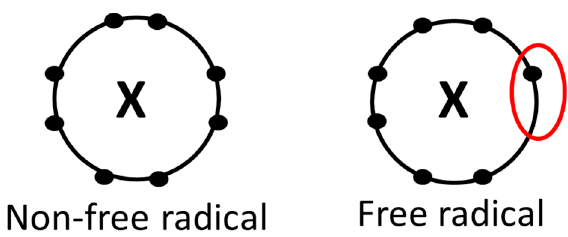
Figure 1. An example of a non-free radical (all electrons within orbital are paired) and a free radical (at least one electron within orbital is unpaired). The superoxide radical has an unpaired electron within its orbital; the unpaired electron creates a reactive compound capable of producing oxidative damage [2,3].